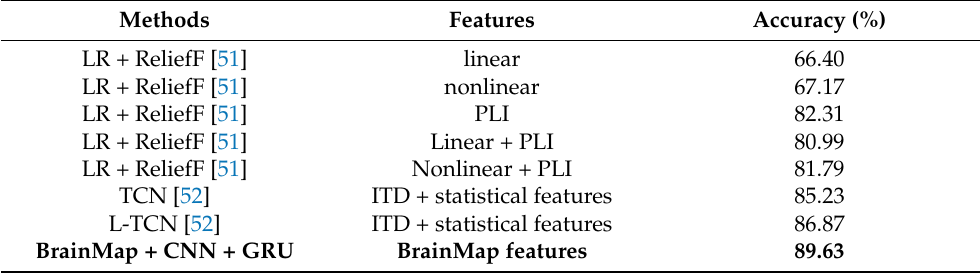
Table 4. Comparison of the classification results between the proposed method and previous works.